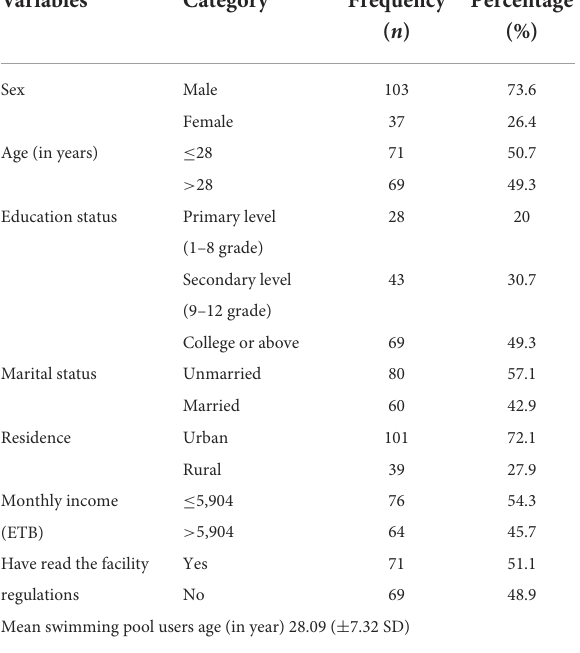
TABLE 1 Socio-demographic characteristics of swimming pool users in Kombolcha Town, Northeastern Ethiopia,